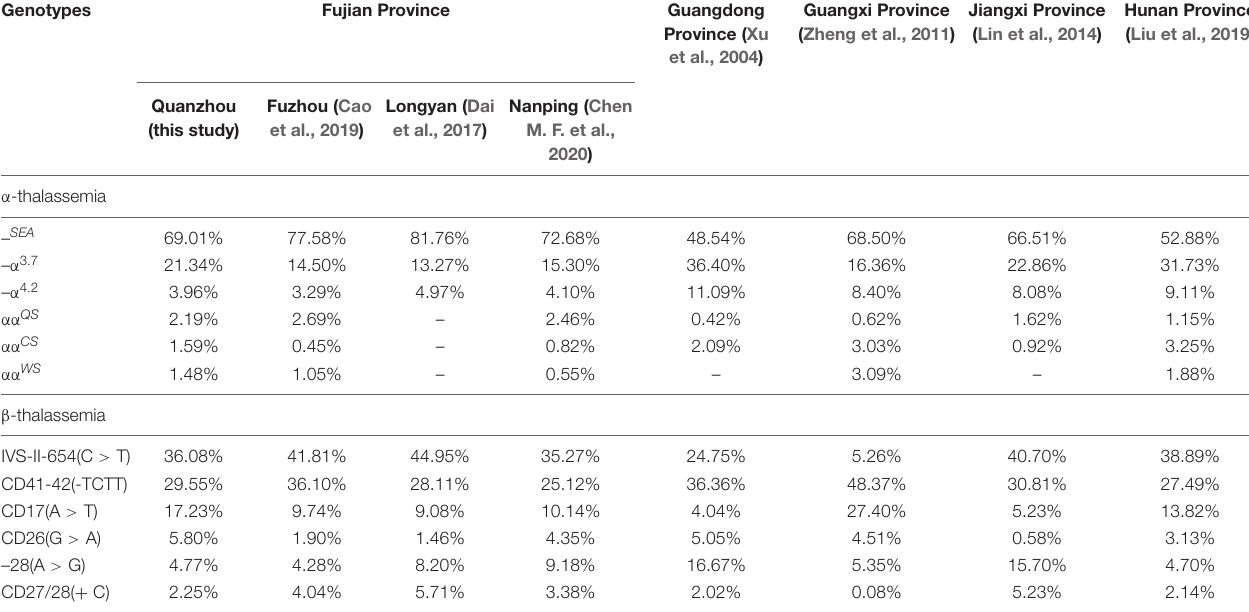
TABLE 7 | Comparison of allele frequency of thalassemia mutations in Fujian and neighboring provinces.